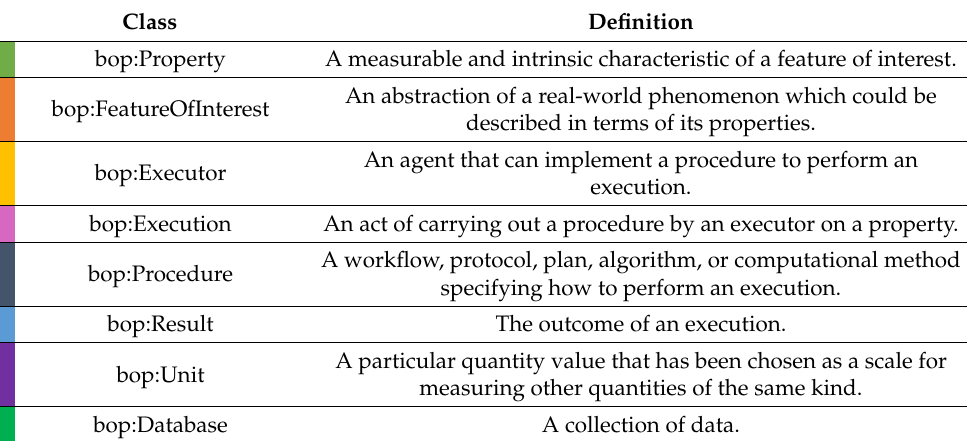
Table 3. Class definitions of